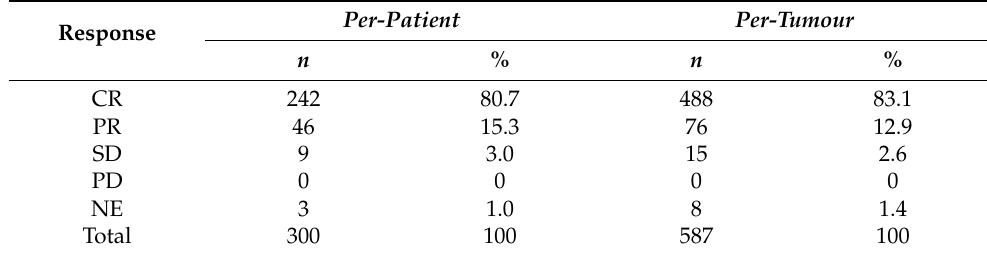
Table 3. Tumour response following the first ECT application ( n = 300 patients with 587